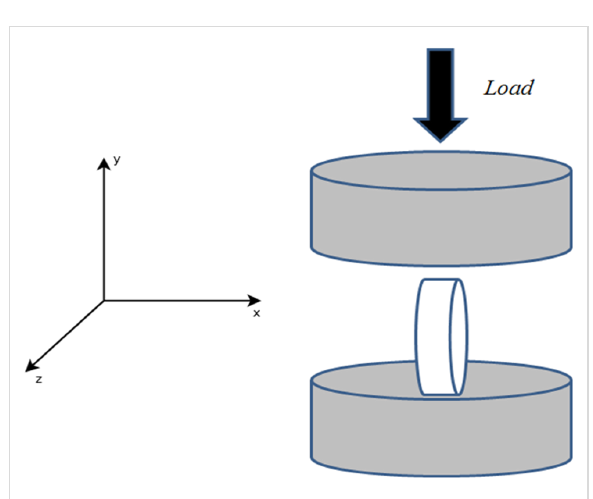
Figure 6: Schematic of diametric compression test of a zeolite pellet along the y -axis.